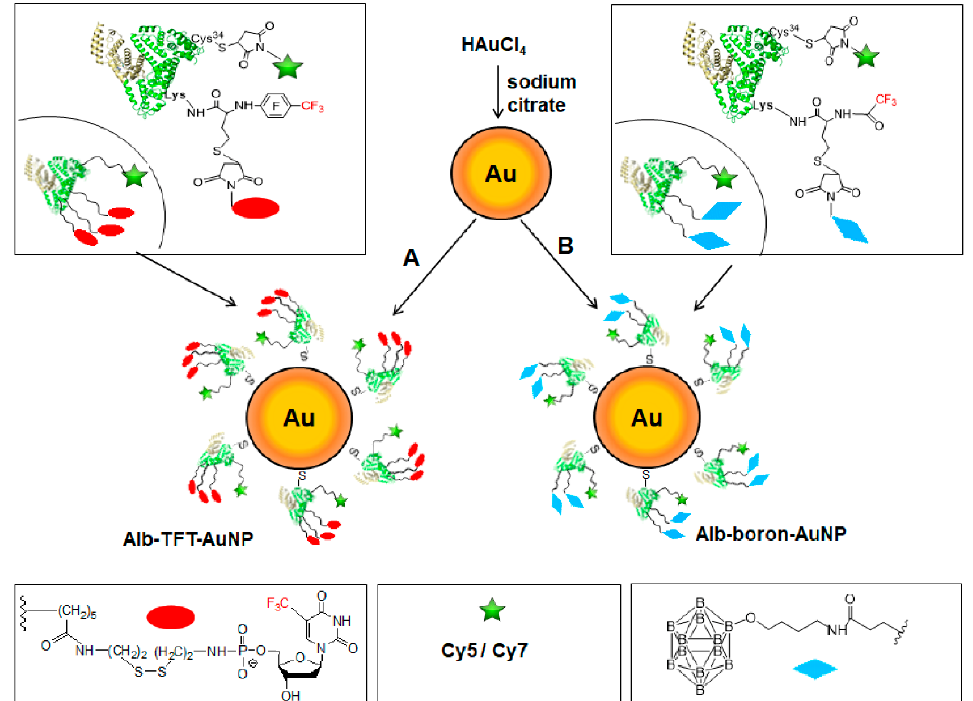
Figure 1. Design of multimodal albumin-gold nanoparticles (AuNPs) theranostic constructs—alb-TFT-AuNP ( A ) and boronated conjugate alb-boron-AuNP ( B ). A protein carrier human serum albumin (HSA) is shown with its crystal structure in ribbon representation. An effector—a chemotherapeutic agent pTFT—is depicted as a red ellipse. Note that pTFT is conjugated with HSA via a linker connecting the 5’-phosphate group of pTFT with ε -amino groups of protein’s residues Lys-525, Lys-205, and Lys-137, which were identified as primary conjugation sites [40]. boron neutron capture therapy (BNCT) agent—undecahydro-close-dodecaborate—is shown as a blue rhombus. The fluorine-labeled homocysteine residues (PFT-Hcy and TFA-Hcy) are used as functional handles (linkers). CF 3 -based 19 F-MR imaging is enabled by the presence of fluorinated compounds (trifluorothymidine (TFT) and trifluoroacetate and perfluorotoluene residues). Optical imaging is achieved due to conjugation of fluorescent dyes Cy7/Cy5 (green star) to Cys-34 residue of HSA.